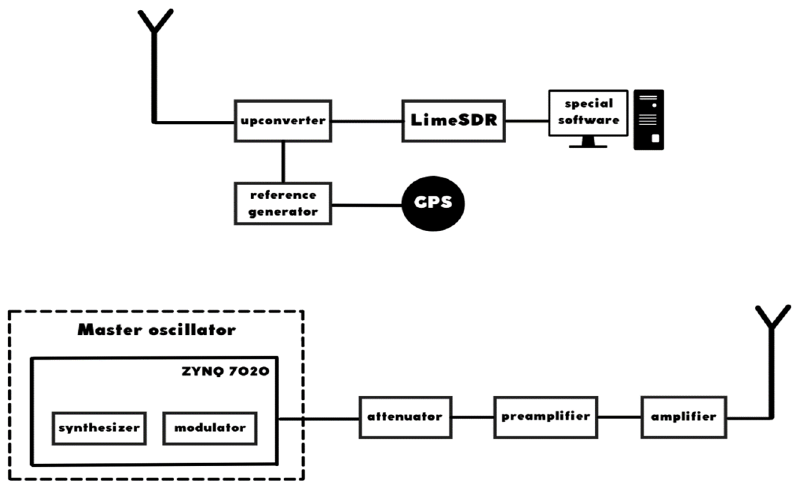
Figure 1. Block diagram of the transmitting ( bottom ) and receiving ( top ) parts of the ionosonde. The Red Pitaya SDRlab 122-16 is the development board based on a Xilinx Zynq 7020 system that combines FPGAs and a general-purpose dual-core ARM processor. The board is equipped with two-channel 14-bit DAC and 16-bit ADC with a sampling rate of 122.88 MS/s, as well as Ethernet and USB2.0 interfaces for data transfer, communication with other devices (PC), and for connecting additional devices to the board (e.g., WI-FI dongle). This board is used as a master oscillator (probe pulse generator). We plan to use this device as a basis for the receiving part of the ionosonde in the